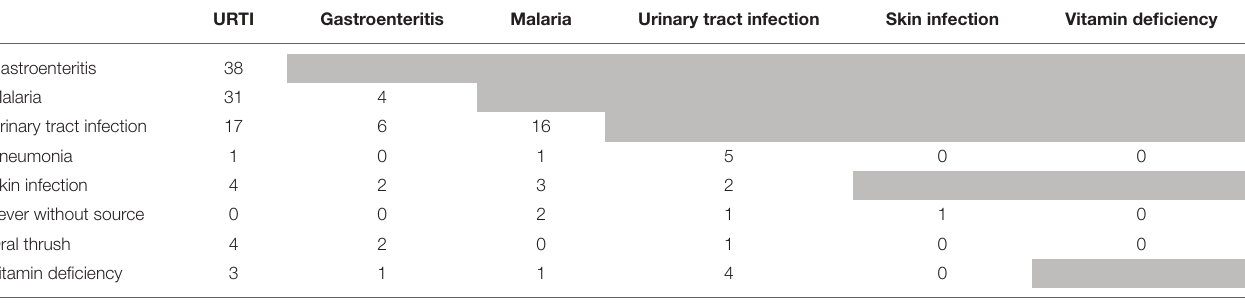
TABLE 2 | Co-occurring diagnoses. URTI Gastroenteritis Malaria Urinary tract infection Skin infection Vitamin deficiency